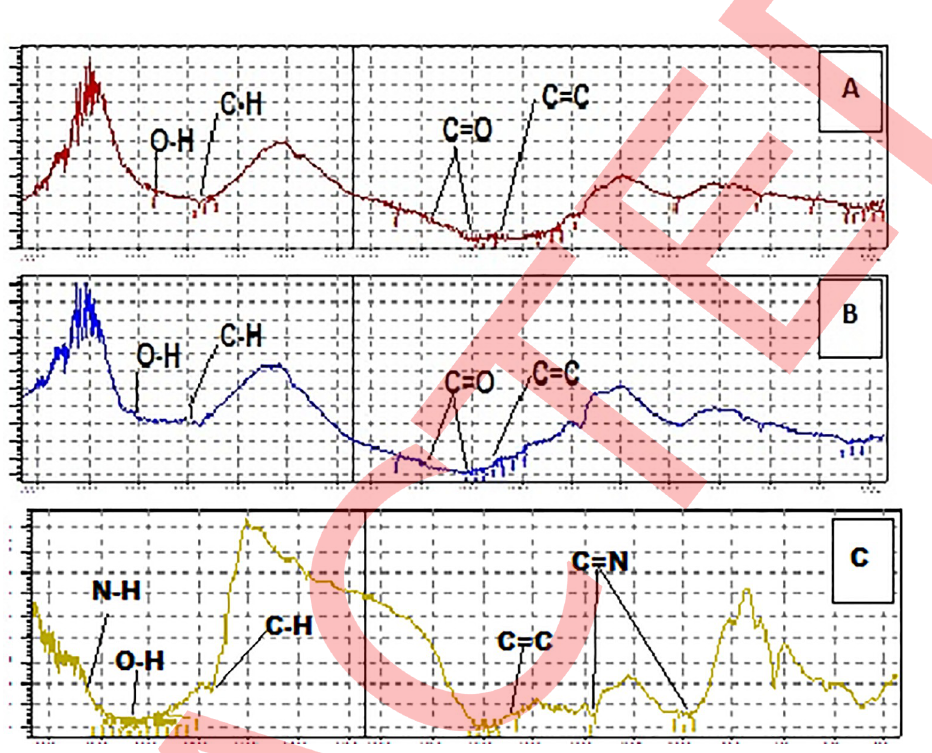
Fig 2. FTIR spectrum of spinach leaves of a plant grown in naturally contaminated soil without BC [A]. FTIR spectrum of spinach leaves of a plant grown in naturally contaminated soil with 3% BC [B]. FTIR spectrum of spinach leaves of a plant grown in naturally contaminated soil with 5% BC